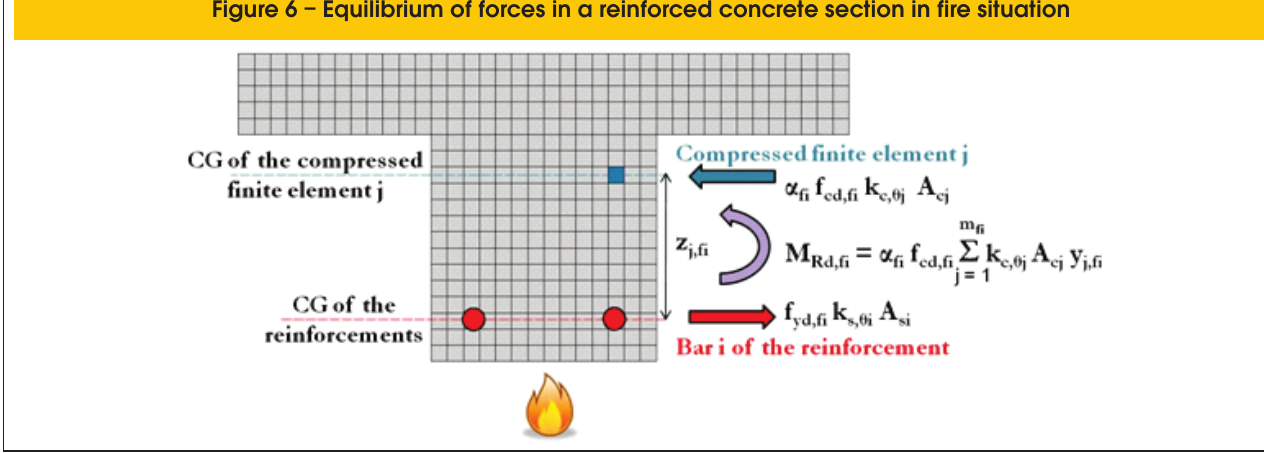
Figure 6 – Equilibrium of forces in a reinforced concrete section in fire